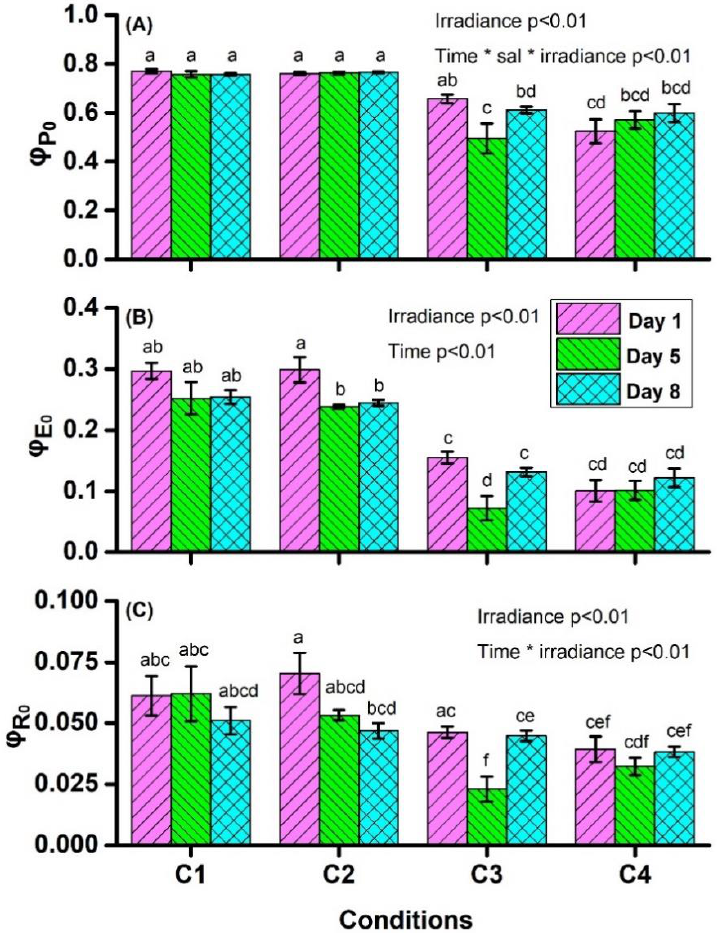
Figure 3. Effects of salinity and irradiance on ( A ) ϕ P0 , ( B ) ϕ E0 , and ( C ) ϕ R0 . Values are means ± standard error, n = 6. * = statistically significant interaction. For further information see Table 1 and Figure 2. The effect of irradiance was significant on the efficiency/probability that an electron moves further than Q A− (ψ E0 ; p < 0.01, Table S1). Mean ψ E0 values (Figure 4A) were higher at 100 μmol photons m −2 s −1 (C1, C2) than at 400 μmol photons m −2 s −1 (C3, C4). The maxi- mum ψ E0 values were observed at C1 on the 1st day and at C2 on the 1st day, while the minimum values were observed at C3 on the 5th day and at C4 on the 5th day. Post hoc comparisons (Table S8) showed that ψ E0 values were significantly lower in C3 and C4 than in C1 and C2. The effect of treatment time was significant on ψ E0 ( p < 0.01, Table S1). Ψ E0 values decreased on the 5th day, but they partly recovered on the 8th day. The effect of irradiance was significant on the efficiency/probability that an electron from the intersystem electron carriers is transferred to reduce end electron acceptors at the PSI acceptor side (δ R0 ; p < 0.01, Table S1). Mean δ R0 values (Figure 4B) were higher at 400 μmol photons m −2 s −1 (C3, C4) than at 100 μmol photons m −2 s −1 (C1, C2). The maximum δ R0 values were observed at C4 on the 1st day and at C3 on the 5th day, while the minimum values were observed at C2 and at C1 on the 8th day. Post hoc comparisons (Table S9) showed that δ R0 values were significantly higher in C3 and C4 than in C1 and C2. The effect of irradiance was significant on the connectivity of PSII photosynthetic units (M 0 ’/M 0 ; p < 0.01, Table S1). Mean M 0 ’/M 0 values (Figure 4C) were higher at 400 μmol